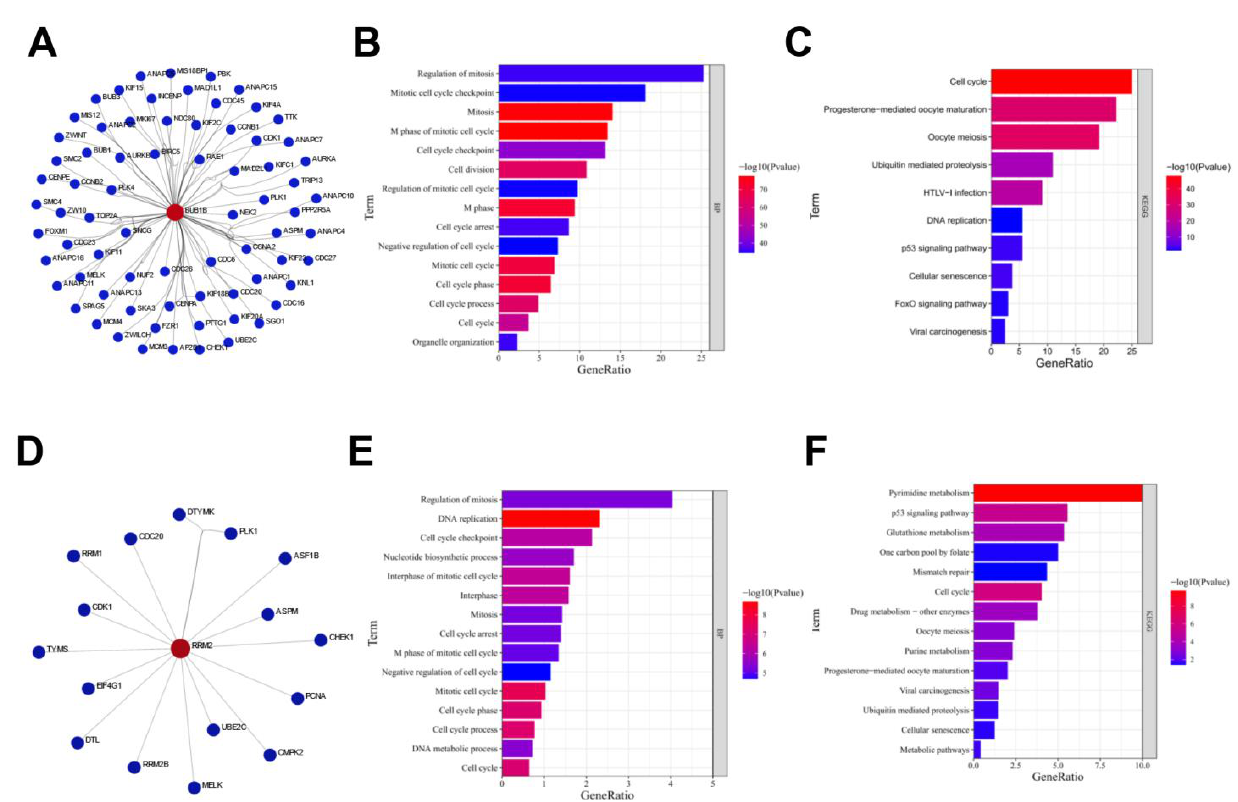
Figure 3. Functional enrichment analysis of proteins interacting with BUB1B or RRM2. ( A ) Protein interaction network of BUB1B. ( B ) BP enrichment analysis of protein interaction network of BUB1B. ( C ) KEGG pathway analysis of protein interaction network of BUB1B. ( D ) Protein interaction network of RRM2. ( E ) BP enrichment analysis of protein interaction network of RRM2. ( F ) KEGG pathway analysis of protein interaction network of RRM2.